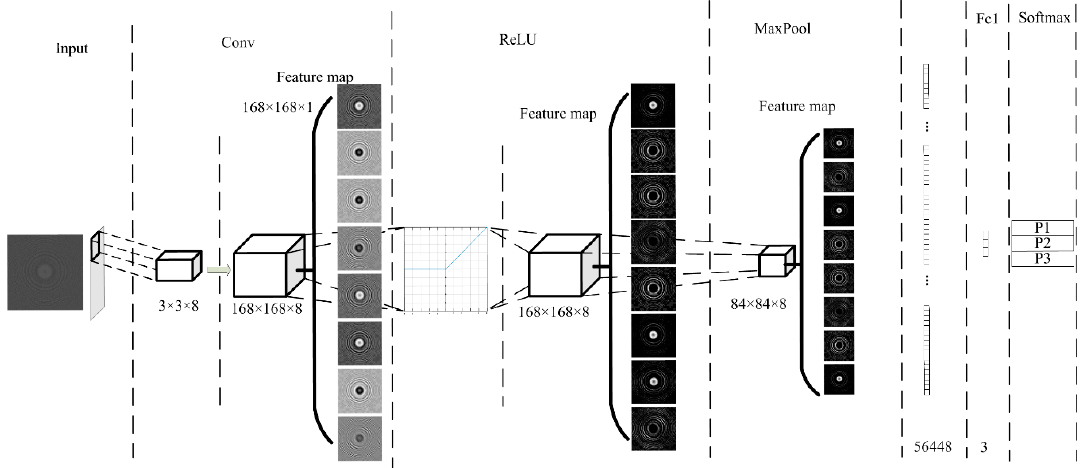
Figure 8. White blood cell (WBC) classification network structure.